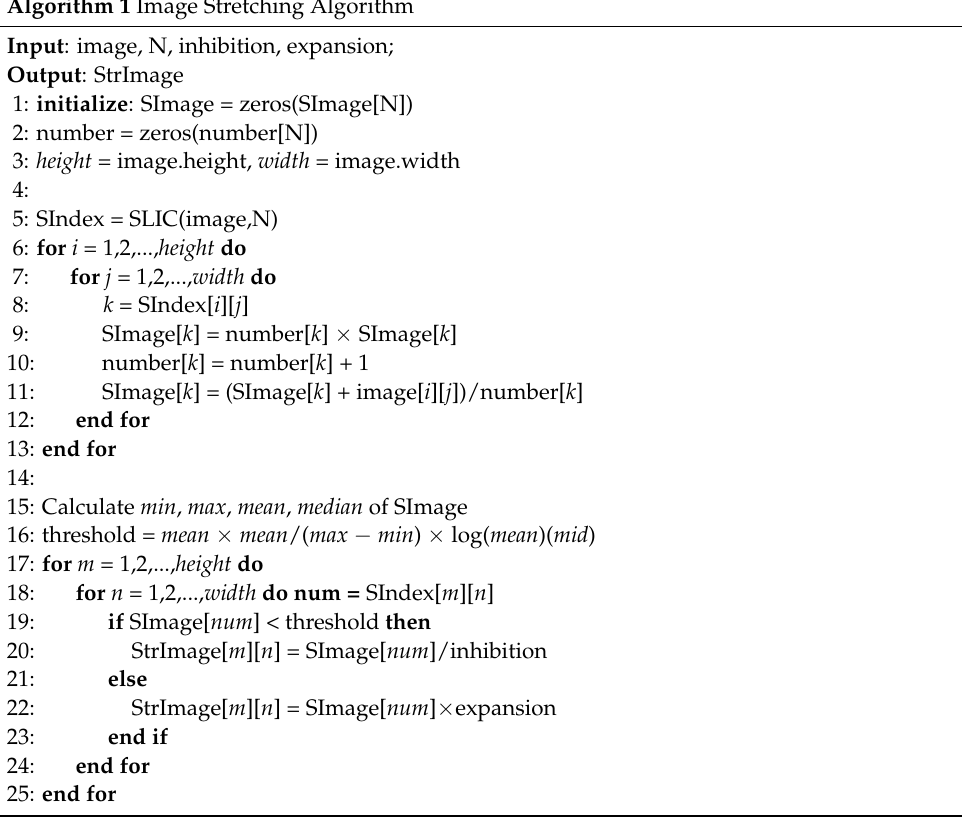
Algorithm 1 Image Stretching